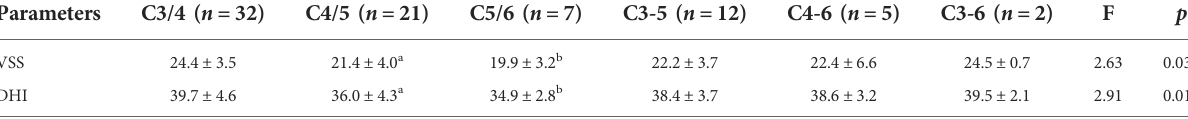
TABLE 3 Preoperative VSS and DHI scores in patients with different cervical segments (x±, n =79).